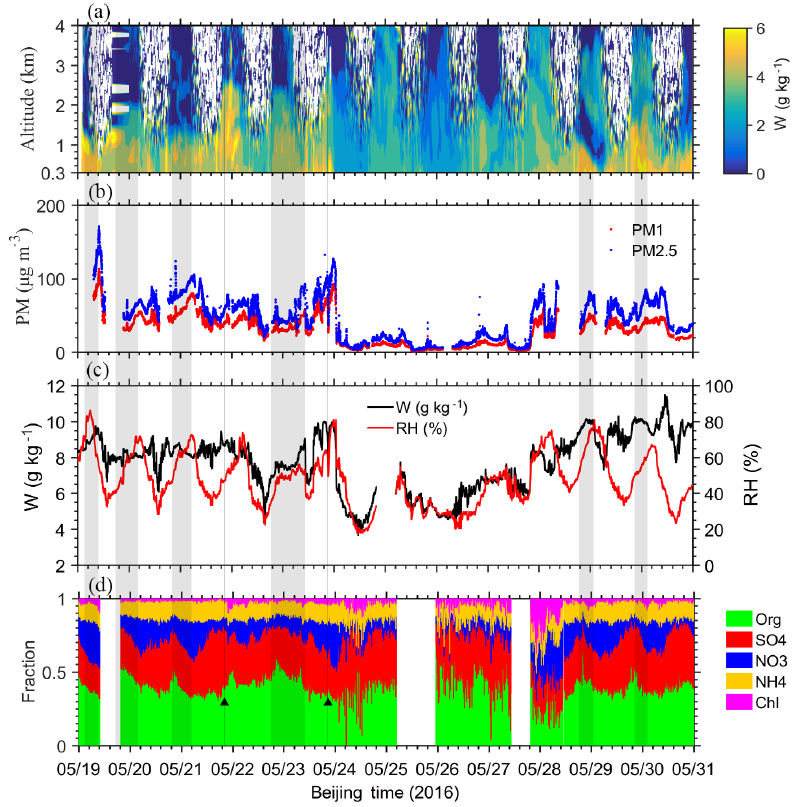
Figure 3. Time series of (a) water vapor mixing ratio ( W ) profiles measured by the Raman lidar, (b) mass concentrations of PM 1 (red dots) and PM 2 . 5 (blue dots), (c) surface W (black line) and relative humidity (RH, red line), and (d) chemical species mass fractions of PM 1 measured by the ACSM. Data are from 19 to 31 May 2016 at Xingtai. The shaded grey areas are to enhance the readability of the article. The black triangles in (d) and grey lines in (a) – (d) represent the two cases chosen for further examination. Blank parts of the data are missing due to uncontrollable factors such as power